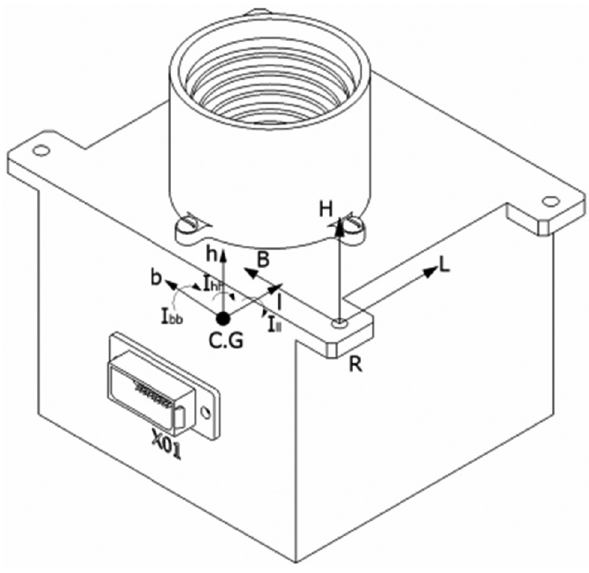
Figure 6: Schematic diagram of the instrument ’ s parameter